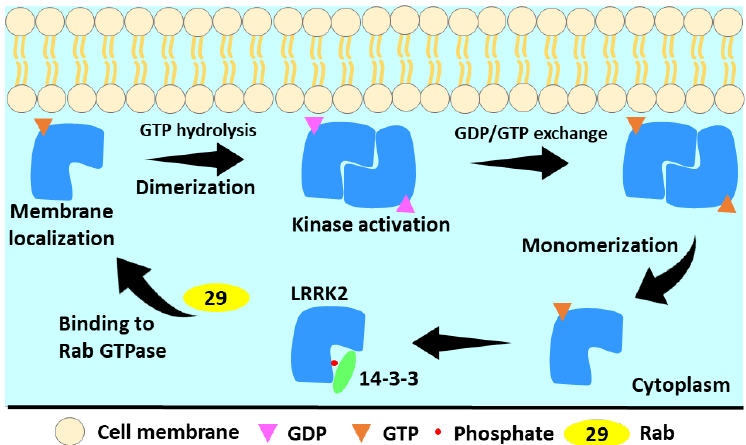
Figure 3. The LRRK2 activation cycle. In the cytosol, LRRK2 is monomeric and GTP-bound. This less active state forms a cytoplasmic complex with 14-3-3 proteins. LRRK2 is membrane-localized by activated Rab proteins. GTP hydrolysis occurs at membrane and results in LRRK2 dimerization. During the GTPase cycle, LRRK2 phosphorylates its substrates. Low LRRK2 affinity for GDP allows quick GDP release, rebinding of GTP, and monomerization of LRRK2 [100].